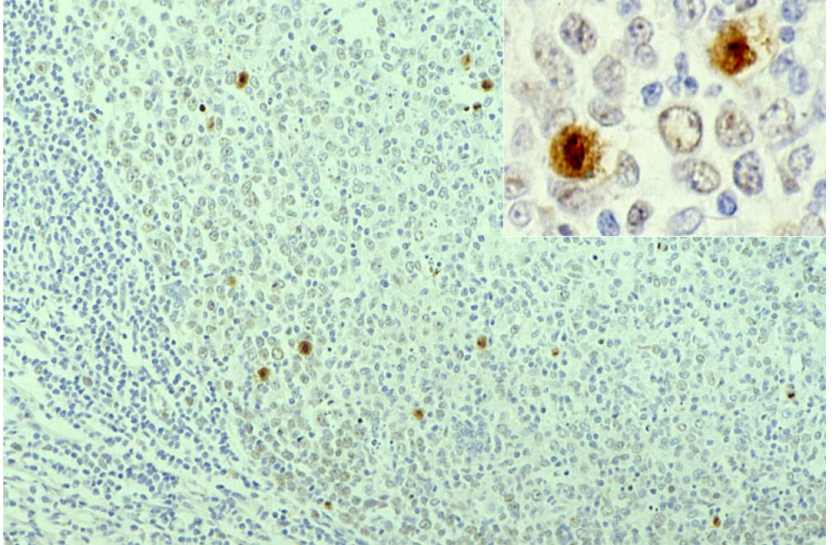
Figure 42. Labeling of mitotic cells by Ki-67 immunostaining in the pharyngeal tonsil (inset: high- power view). A high-molecular-weight polymer reagent in the EnVision system provokes a false- negative result for Ki-67 nuclear labeling of proliferative cells. Only mitotic cells are labeled. It seems that the huge molecules of the secondary reagent cannot reach the non-mitotic proliferative cells but do reach the mitotic cells lacking the nuclear